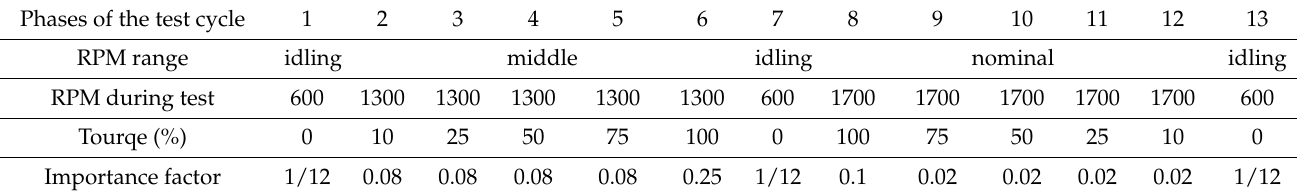
Table 6. Phases of the test cycle with their importance factors—values required by the UNECE Regulation No. 49 [49]. Phases of the test cycle